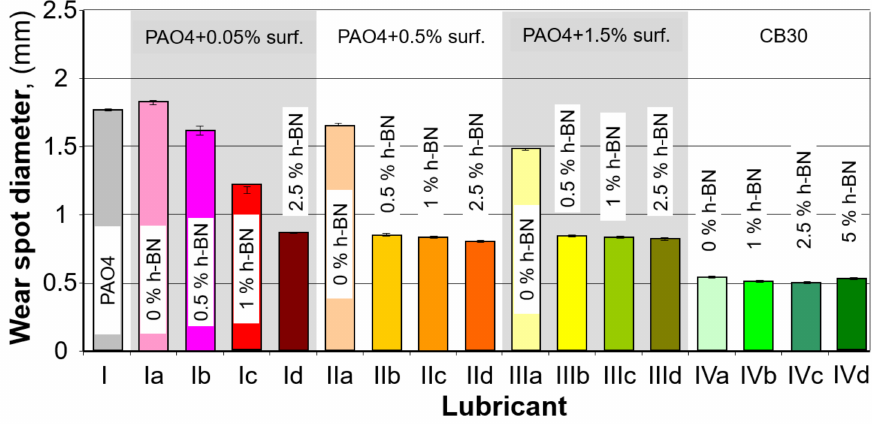
Figure 5. Summary of wear spot diameter measurement